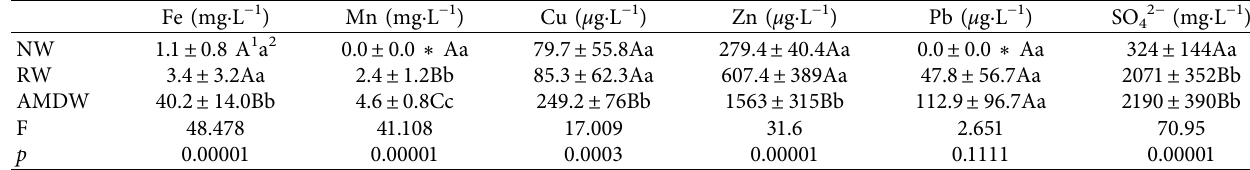
Table 1: The Duncan multiple comparison of the typical pollution ions among NW, RW, and AMDW. Fe (mg · L − 1